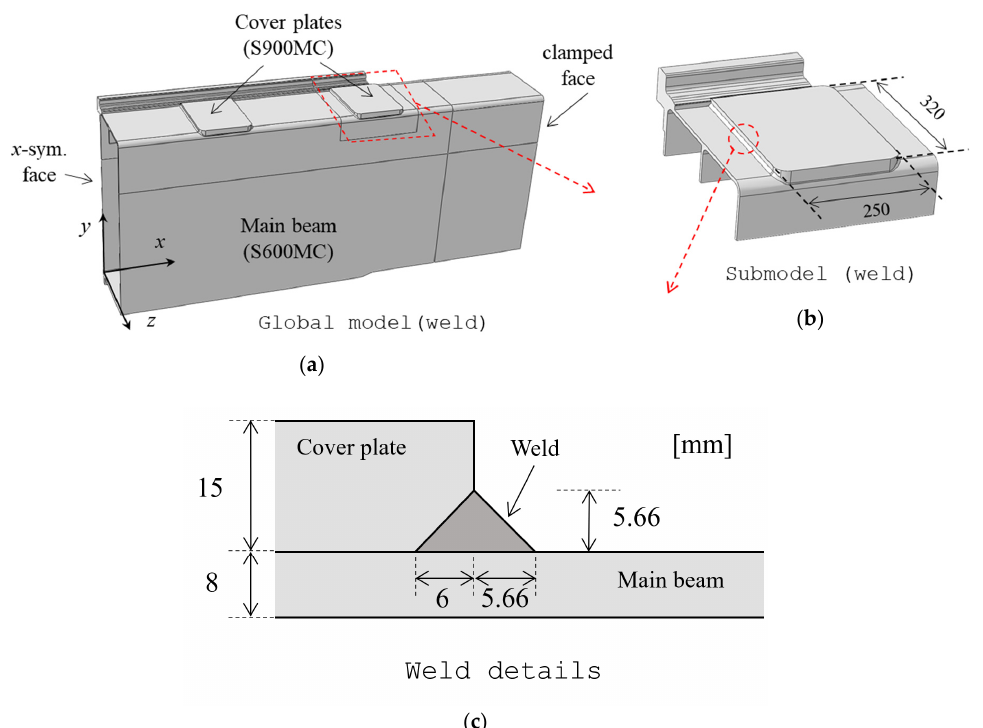
Figure 9. Model for the welded configuration showing: ( a ) the global model, ( b ) the submodel and ( c ) dimensions of the weld.